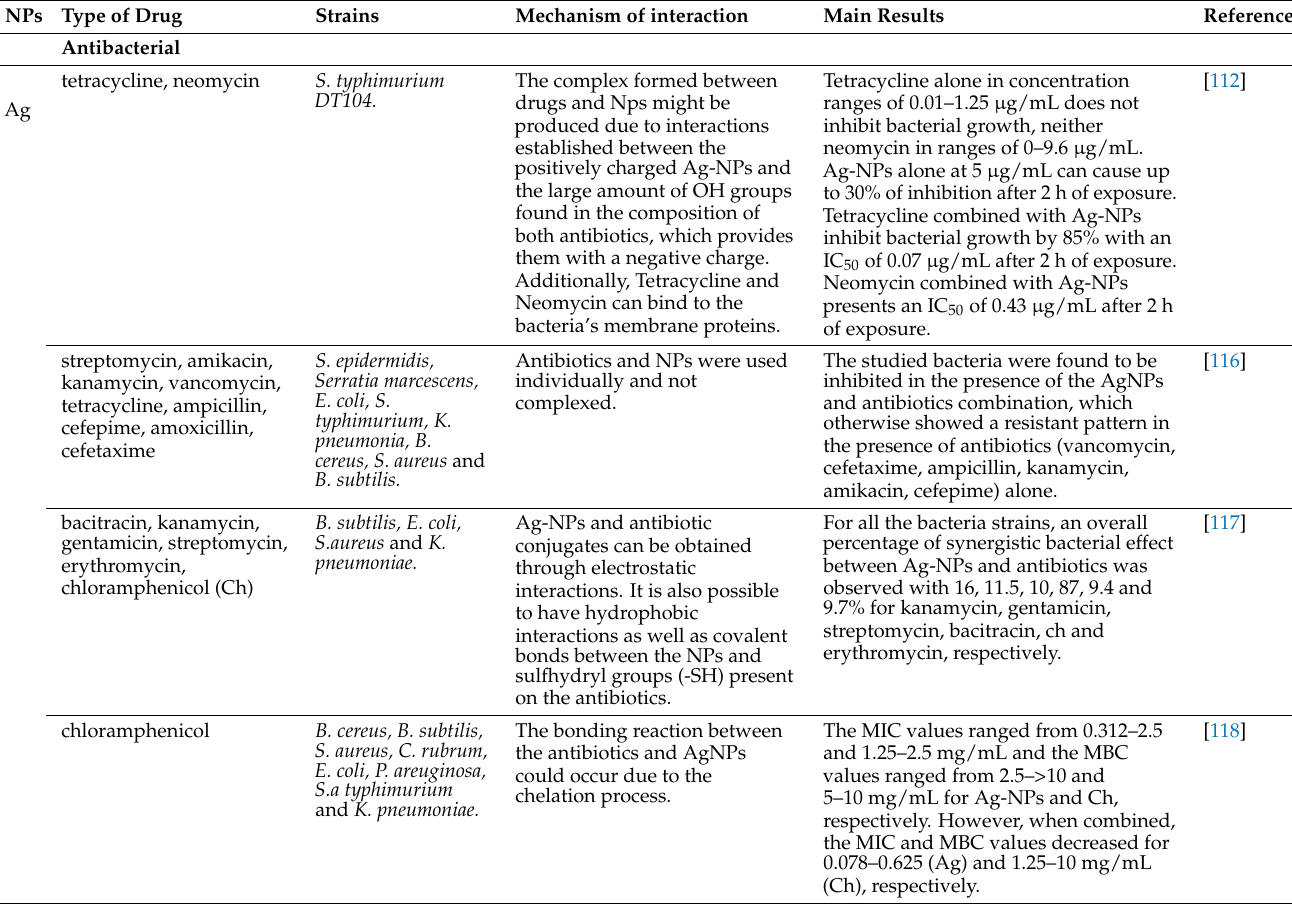
Table 4. Synergistic interactions between different types of M-NPs and